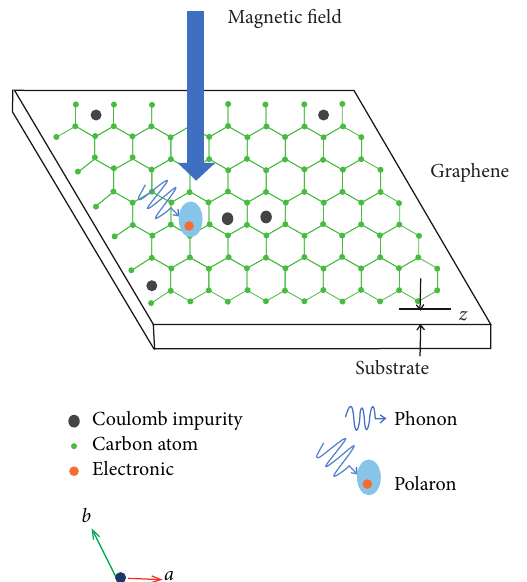
Figure 1: Schematic diagram of magnetopolaron in graphene with Coulomb impurities under the